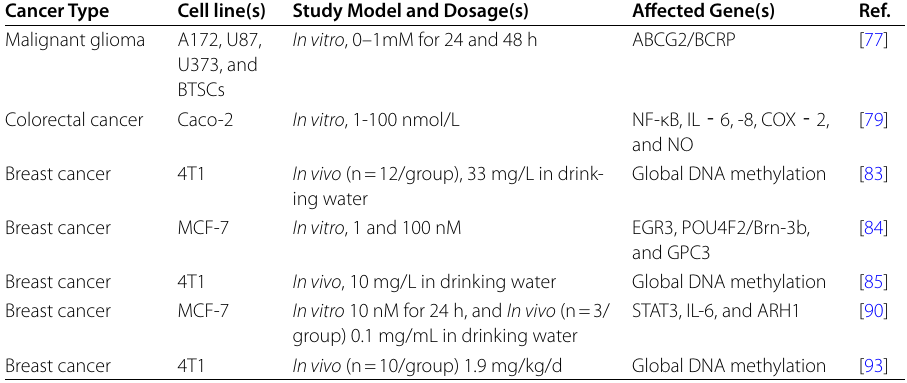
Table 1 Studies that investigated the melatonin-induced modification of DNA methylation against cancer